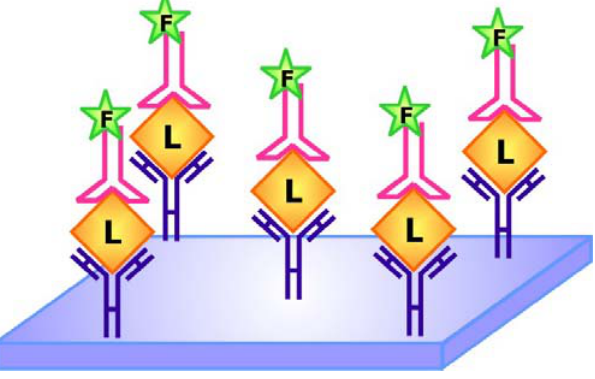
antibodies to capture a ligand of interest and fluorescently-labeled aptamers as a reporter for target detection